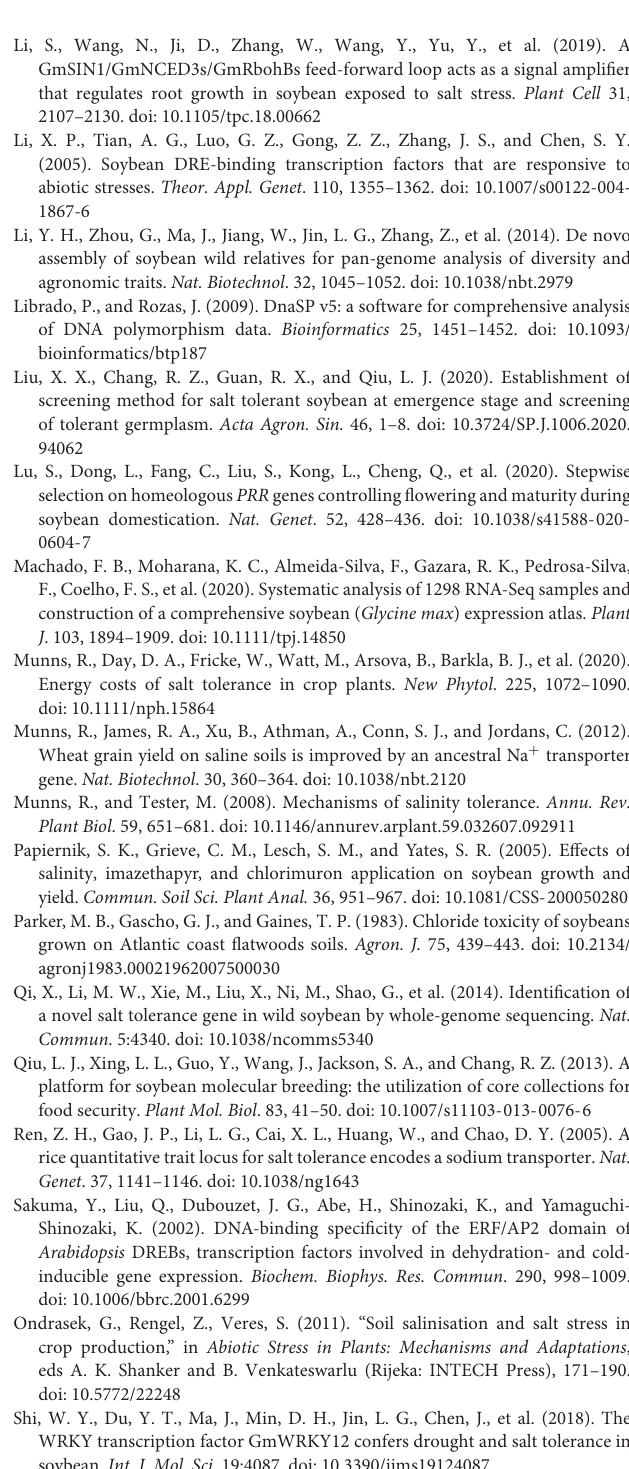
Supplementary Figure 9 | Haplotype origins of DREB3a and DREB3b . Supplementary Figure 10 | Boxplots for yield-related traits based on the haplotypes of DREB3b gene. (A) Flowering time. (B) Plant height. (C) 100-grain weight. One-tailed Student’s t -test was used to generate the P -values.